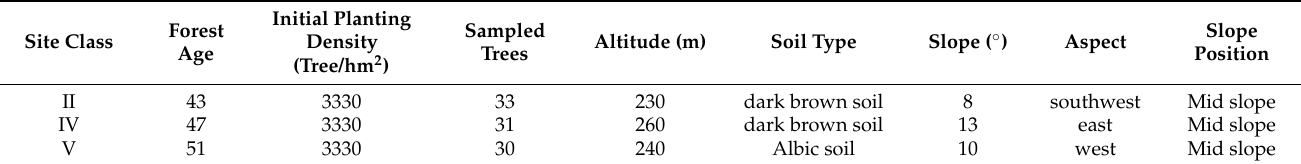
Table 1. Characteristics of sampled Larix olgensis